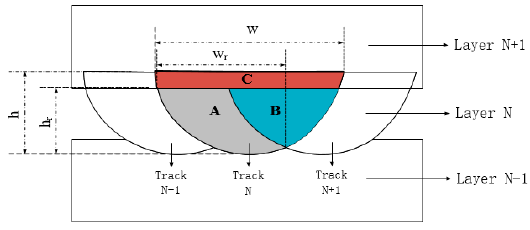
Figure 9. Analysis of the molten pool remelting area.